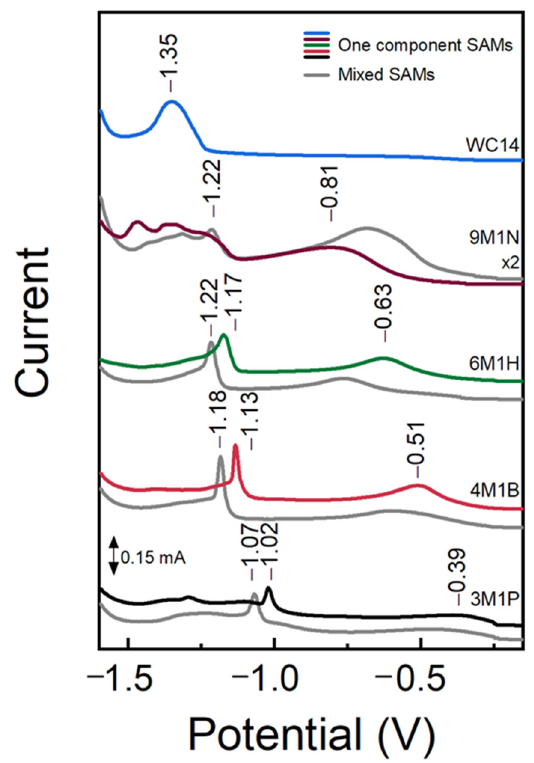
Figure 3. Potentiodynamic curves of one component SAMs (colored lines) and mixed component SAMs (80% backfiller: 20% WC14) (grey lines). Reductive desorption was performed from Ag film in 0.5 M NaOH + 0.1 M Na 2 SO 4 deaerated aqueous solution at the sweep rate of − 50 mV/s. The desorption curves of 9M1N and 9M1N + WC14 SAMs were multiplied by two.